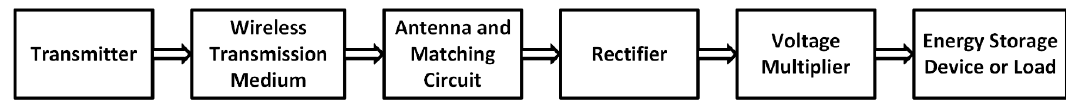
Figure 1. Block diagram of an RFEH system.